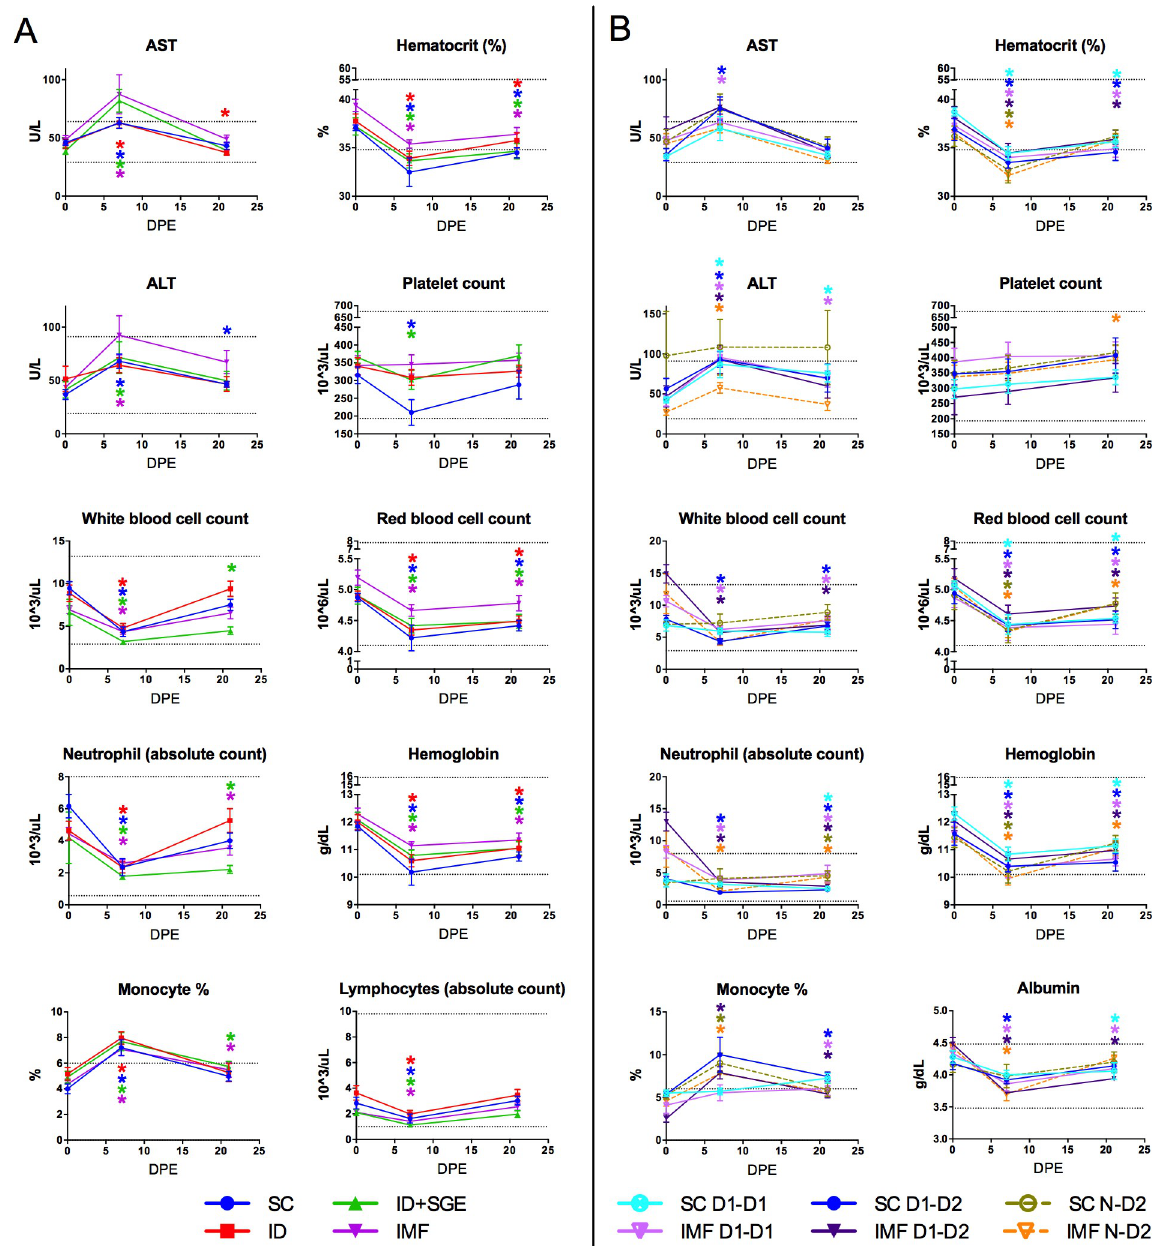
Fig 2. Hematology and clinical chemistries following primary and secondary DENV exposures. Data were measured on study days 0, 7, and 21 post A) primary DENV-1 infection via different routes/modalities and B) homologous DENV-1 re-exposure, heterologous DENV-2 infection, and primary DENV-2 infection. Analyses were based on an ANOVA model on the change from baseline with the covariates baseline value of the variable and baseline weight and group as factors. n = 10 for each SC, ID+SGE, and IMF; n = 9 for ID; n = 5 for the remainder of groups. ( � , p < 0.05). SC, subcutaneous; ID, intradermal; ID+SGE, intradermal + salivary gland extract; IMF, infectious mosquito feeding; D1-D1, homologous DENV-1; D1-D2, heterologous DENV-2; N-D2, primary